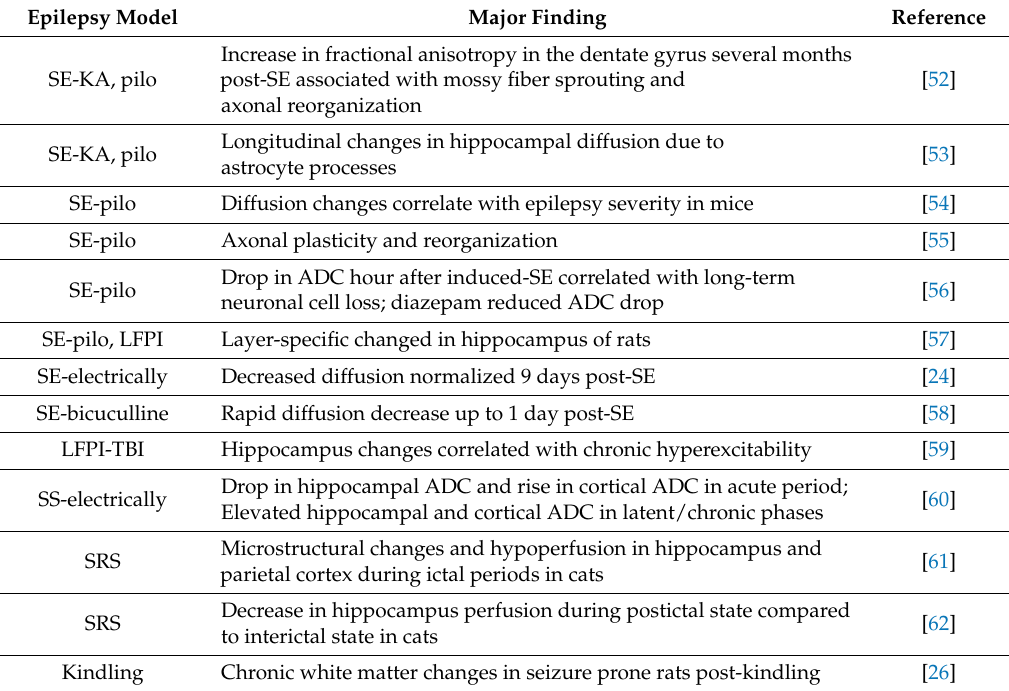
Table 5. List of diffusion MRI studies and potential biomarkers for